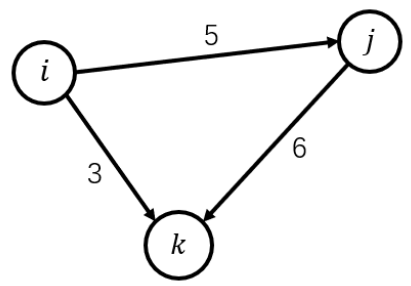
Figure 1. Passing network